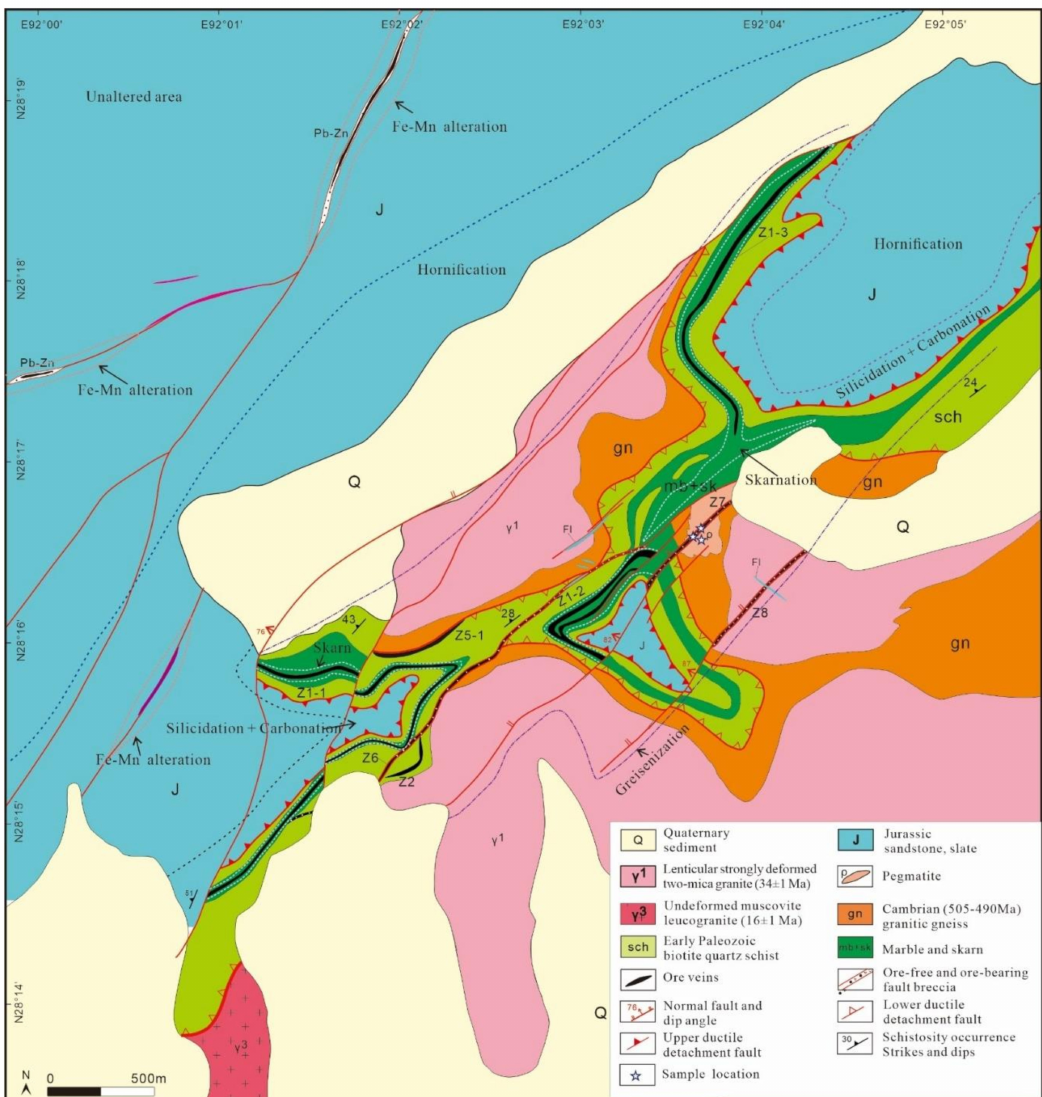
Figure 3. Geological map and sample location of Xianglin in the Cuonadong